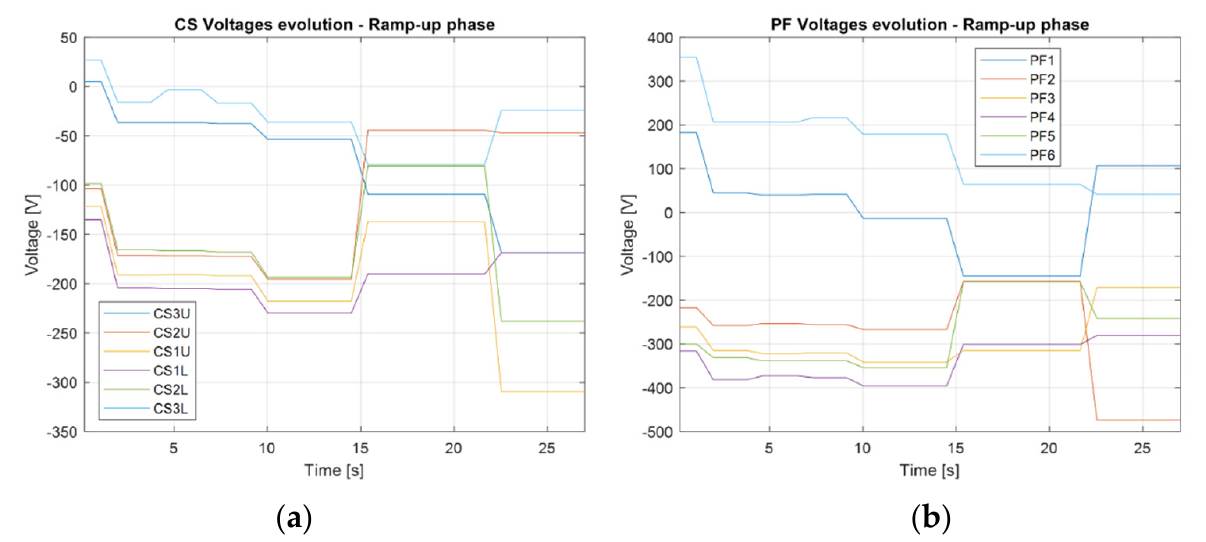
Figure 3. Time evolution of plasma shapes of the DTT ramp-up phase with a plasma current rate equal to 200 kA/s.